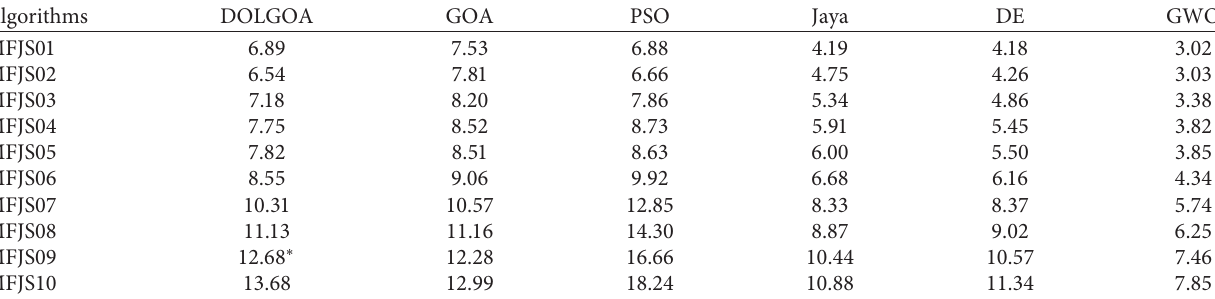
Table 9: The CPU time periods obtained by algorithms for solving